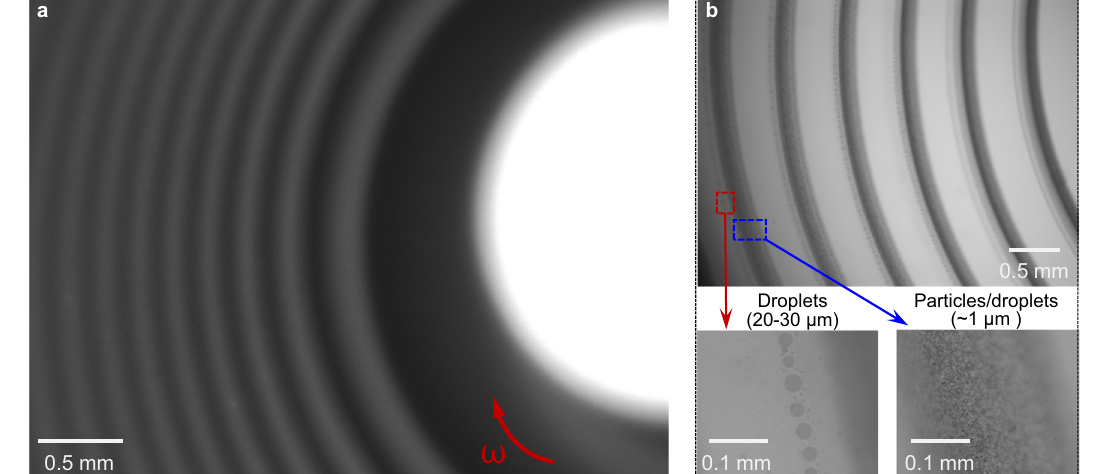
Fig. 4 | Composition of the fi lament and spiral patterns. a Formation of spiral patterns by the addition of a 1 μ L DEX-CaCl 2 (50mM) droplet with Rhodamine 6G (0.05%) to a round cell (diameter 15.8mm) fi lled with PEG-SDBS (2.5mM) solution (depth 2.5mm). The photo was taken under a fl uorescent microscope.